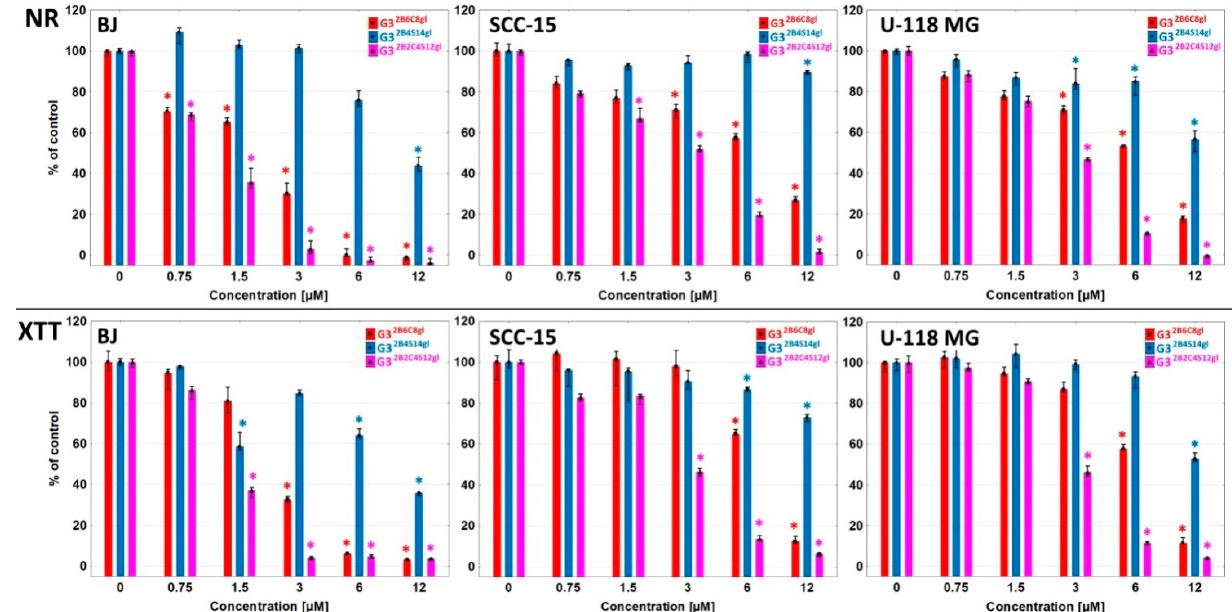
Figure 3. Cytotoxicity of single conjugates G3 2B6C8gl , G3 2B4S14gl , and combined conjugate G3 2B2C4S12gl for normal (BJ) and cancer (SCC-15) and (U-118 MG) cells after 24 h treatment, estimated with neutral red (NR) or XTT assay. Cell viability is presented as medians of a percent against non-treated control (control expressed as 100%). The whiskers are lower (25%) and upper (75%) quartile ranges. * p ≤ 0.05; Kruskal–Wallis test (against non-treated control).